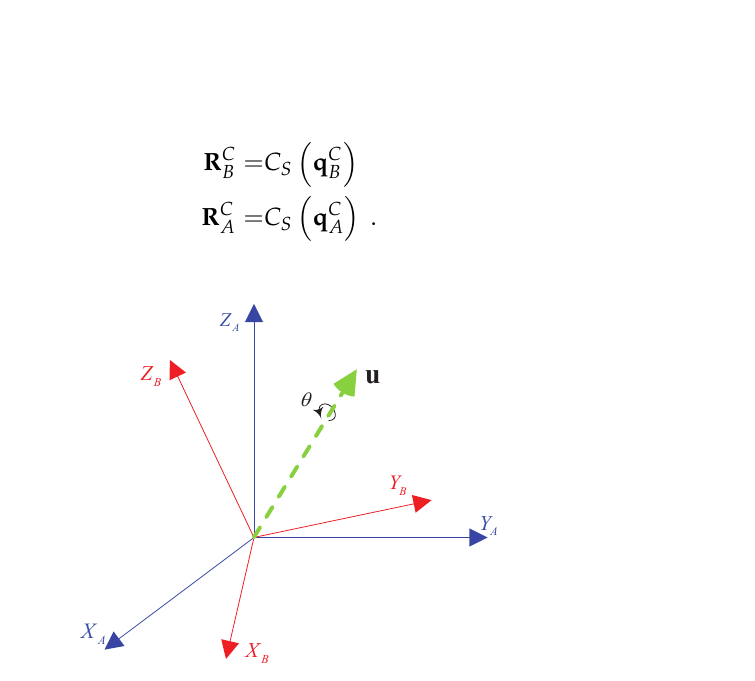
Figure 1. Rotation of frame A into frame B